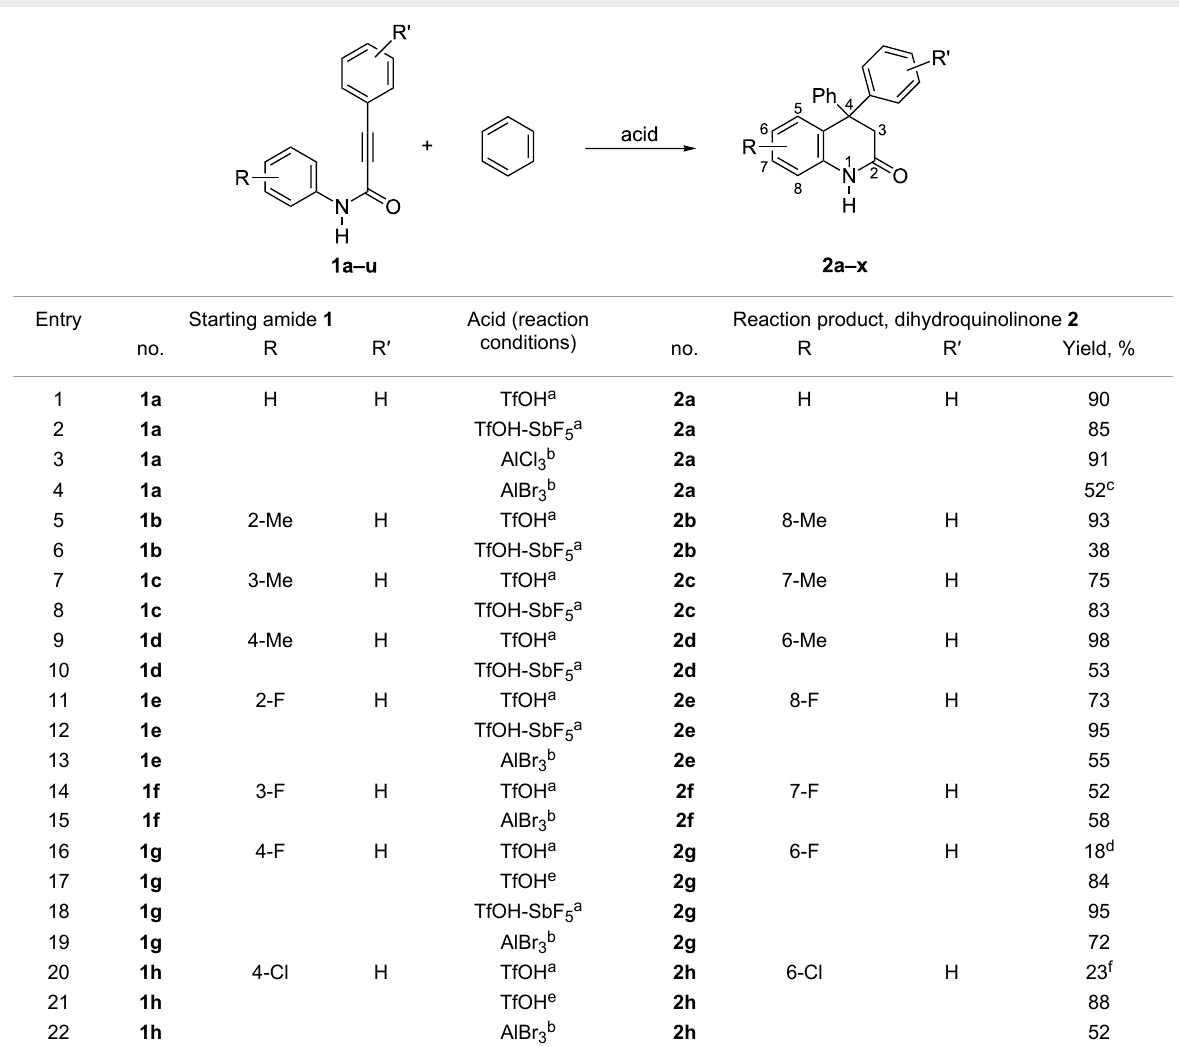
Table 1: Reactions of amides 1a–u with benzene (and other arenes) under superelectrophilic activation, leading to dihydroquinolinones 2a–x .